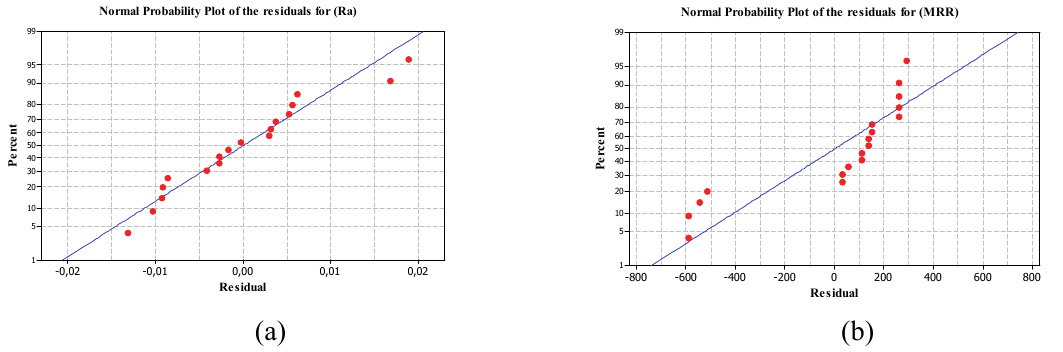
Fig. 8. Normal probability plot of residuals for: (a) surface roughness, (b) material removal rate Fig. 9 (a, b) shows the residuals which are associated with the eighteen experimental runs of surface roughness and material removal rate, respectively. This residual is equal to the difference between the observed and predicted values of the output responses. The residuals of surface roughness belong to the interval of -0.015 to 0.020 µm versus the residuals of material removal rate, which belong at the interval of -600 to 400 mm 3 /min. The residuals do not represent any obvious pattern, this implies that the predictive equations are reliable for estimating the responses at any particular design points which belong at the range intervals selected in this study.